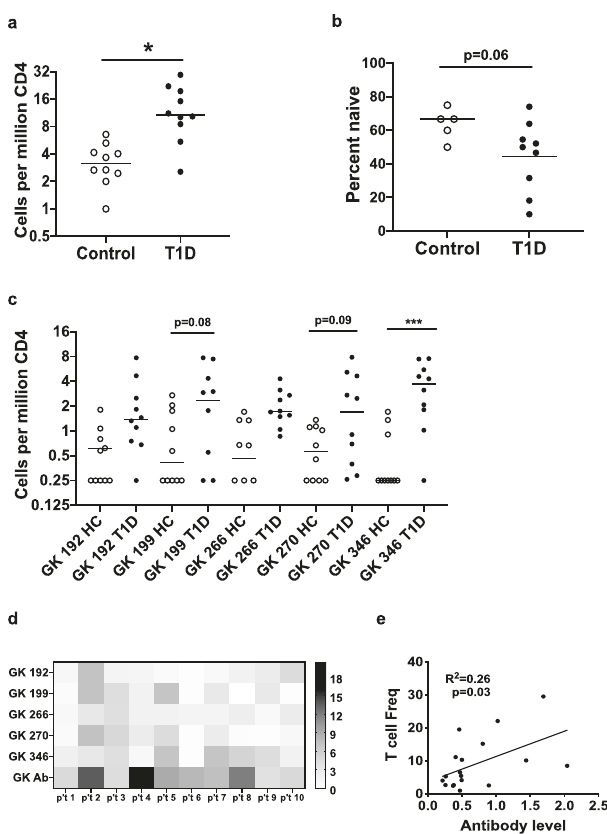
Fig. 3 GK speci fi c CD4 + T cells are more frequent in subjects with T1D and are correlated with anti-GK antibodies. a Comparison of total GK reactive CD4 + T cell frequencies in the peripheral blood of 10 healthy controls and 10 subjects with T1D. The total frequencies of glucokinase- reactive T cells (GK 192, 199, 266, 270, and 346 combined) were signi fi cantly higher (*; p = 0.0007, Mann Whitney test) in subjects with T1D (black circles) than in HLA matched controls (white circles). b GK speci fi c CD4 + T cells tended to be more naïve (CD45RA + CR7 + ) in healthy controls than in subjects with T1D ( p = 0.064, Mann Whitney test). c Individual frequencies were signi fi cantly higher in subjects with T1D (black circles) than in healthy controls (white circles) for GK 346 (***; p = 0.0004, ANOVA followed by Sidak ’ s multiple comparisons test). Individual frequencies trended toward being higher for GK 199 and GK 270 ( p = 0.08 and p = 0.09 respectively) but did not reach statistical signi fi cance. d A heatmap analysis of individual GK T cell frequencies in subjects with T1D, indicating patterns of reactivity that differed between subjects. In the heatmap each column represents one subject and each row re fl ects one GK speci fi city, with each square color coded to indicate the observed T cell frequency in cells per million. The antibody readout is indicated at the bottom individually. e There was a signi fi cant positive correlation between the combined frequency of GK-reactive T cells and levels of anti-glucokinase antibodies ( p = 0.030, simple linear